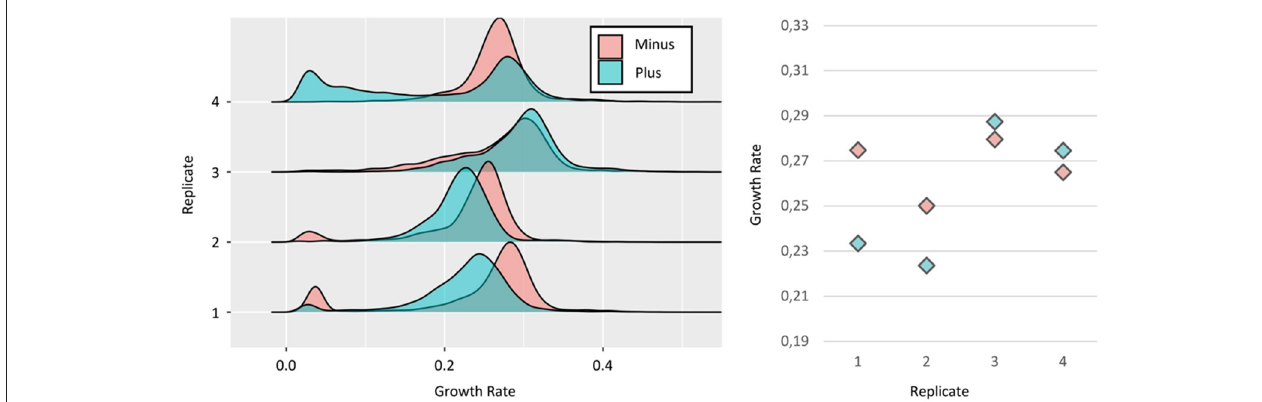
FIGURE 3 | Relationship between TSL1 expression and growth. (Left) Growth rates distributions of Minus (red) and Plus (blue) sorted subpopulations, from four independent replicates of the strain Ntd-Tsl1. As explained in Figure 1C , the growth rate of each individual microcolony was calculated from three time intervals (t2 to t5). (Right) Median growth rates of the distribution for Minus and Plus cells, respectively: replicate #1 ∼ 0,27 and ∼ 0,23 h − 1 ; replicate #2 ∼ 0,25 and ∼ 0,22 h − 1 ; replicate #3 ∼ 0,27 and ∼ 0,28 h − 1 ; replicate #4 ∼ 0,26 and ∼ 0,27 h − 1